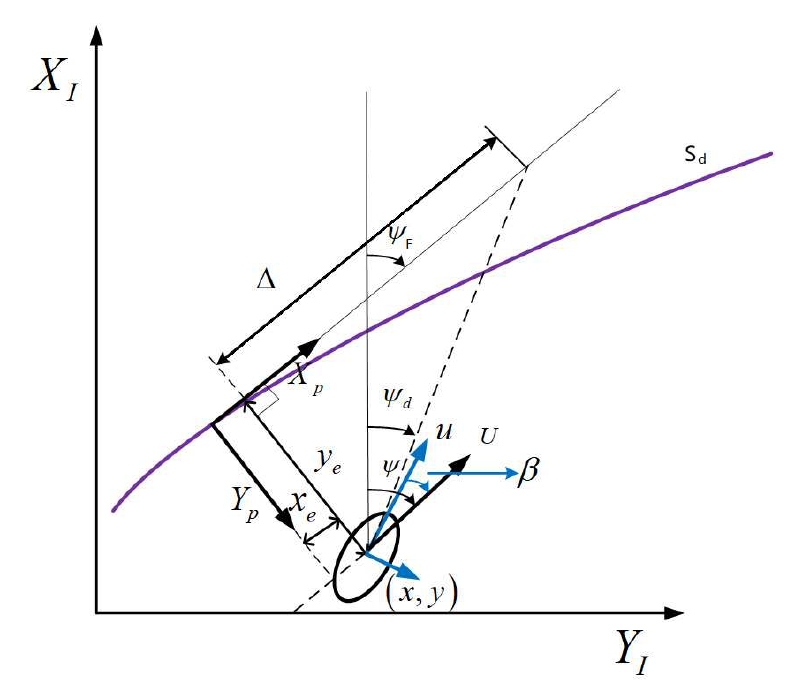
Figure 1. Schematic diagram of USV path-following